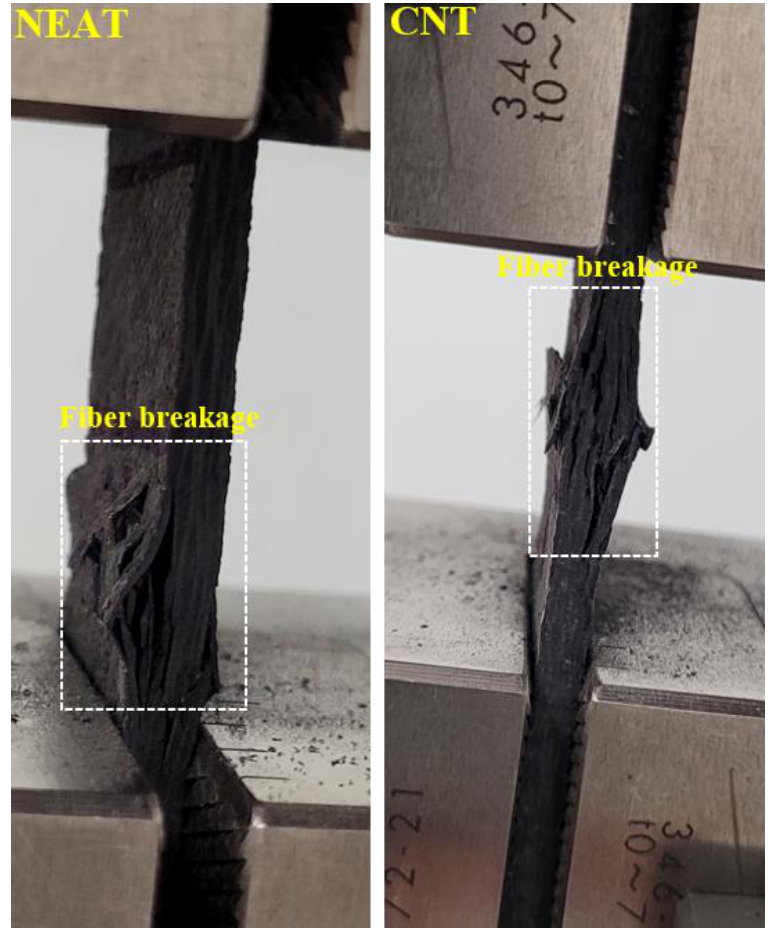
Figure 7. Macro damage in the samples. Table 6. The buckling load and vertical displacements of simple–simple supported samples.